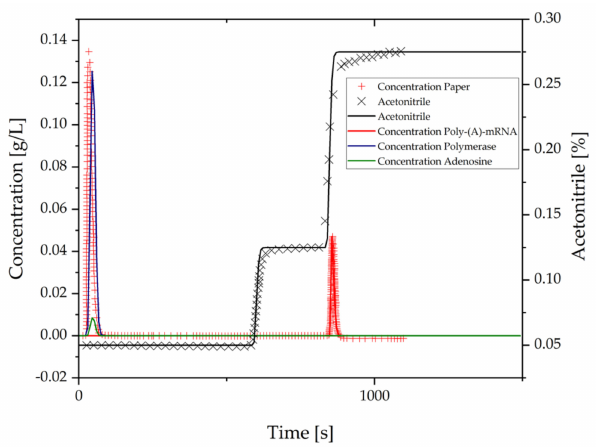
Figure 18. Laboratory data of the RP monolith is given as symbols; simulated data is given as lines.